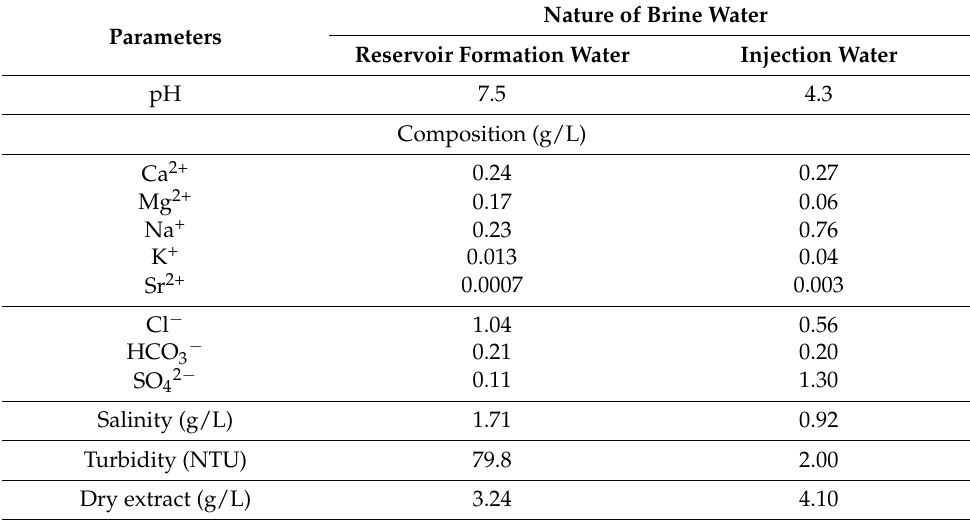
Table 1. Chemical composition of brines used for rheology